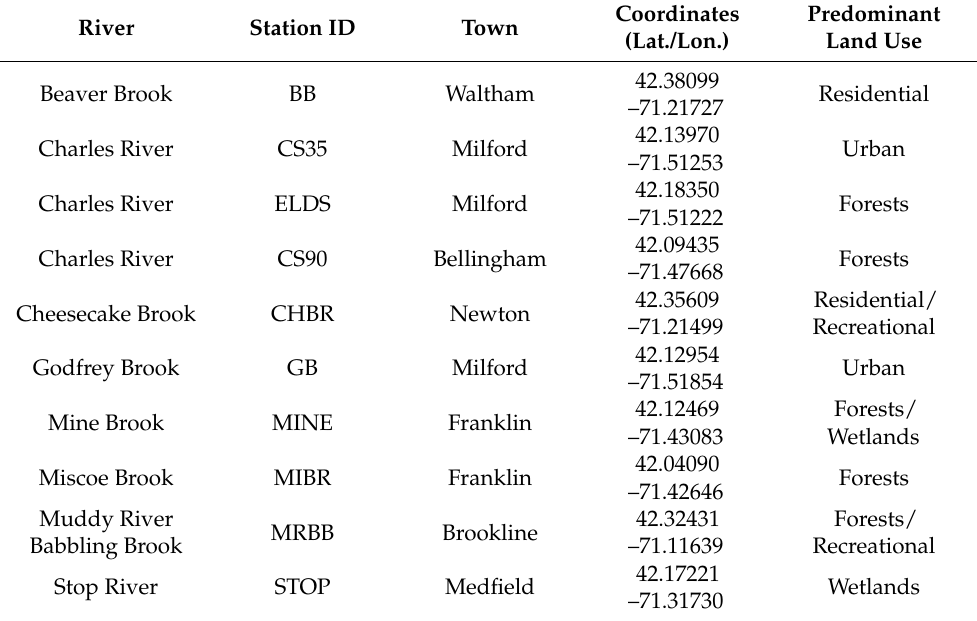
Table 1. Summary of river, station ID, town, coordinates (Latitude/Longitude), predominant land use for the ten 100-meter reach stations sampled in 2012 in the Charles River watershed,